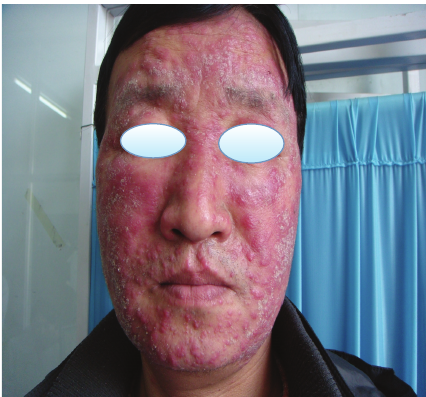
Figure 1: Erythema, papule and nodules, and desquamation over the whole face.